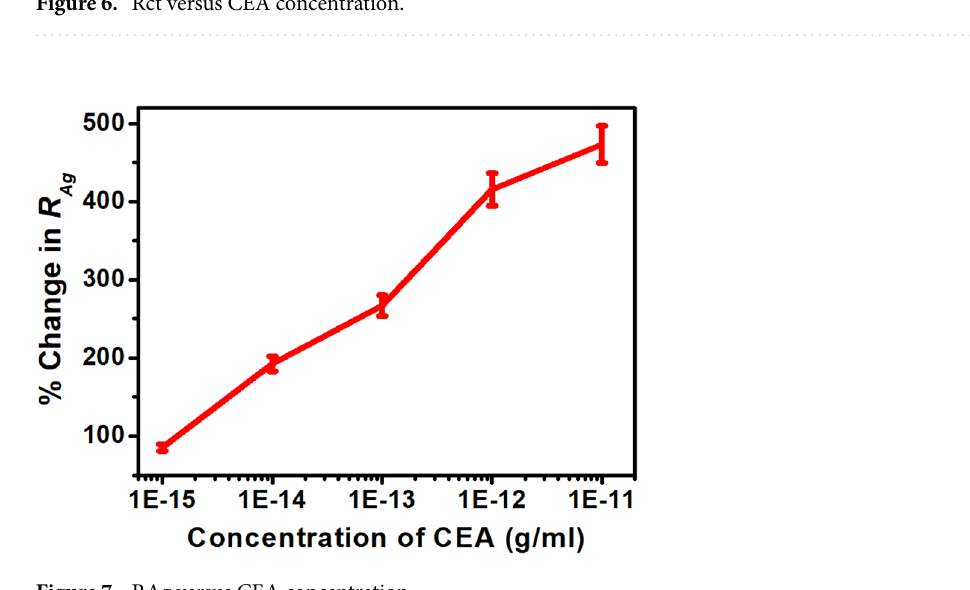
Figure 7. RAg versus CEA